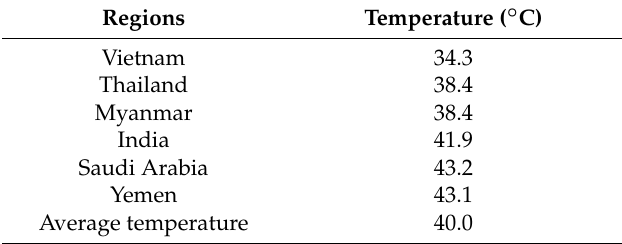
Table 3. Average outdoor temperature of the Southeast Asian region.